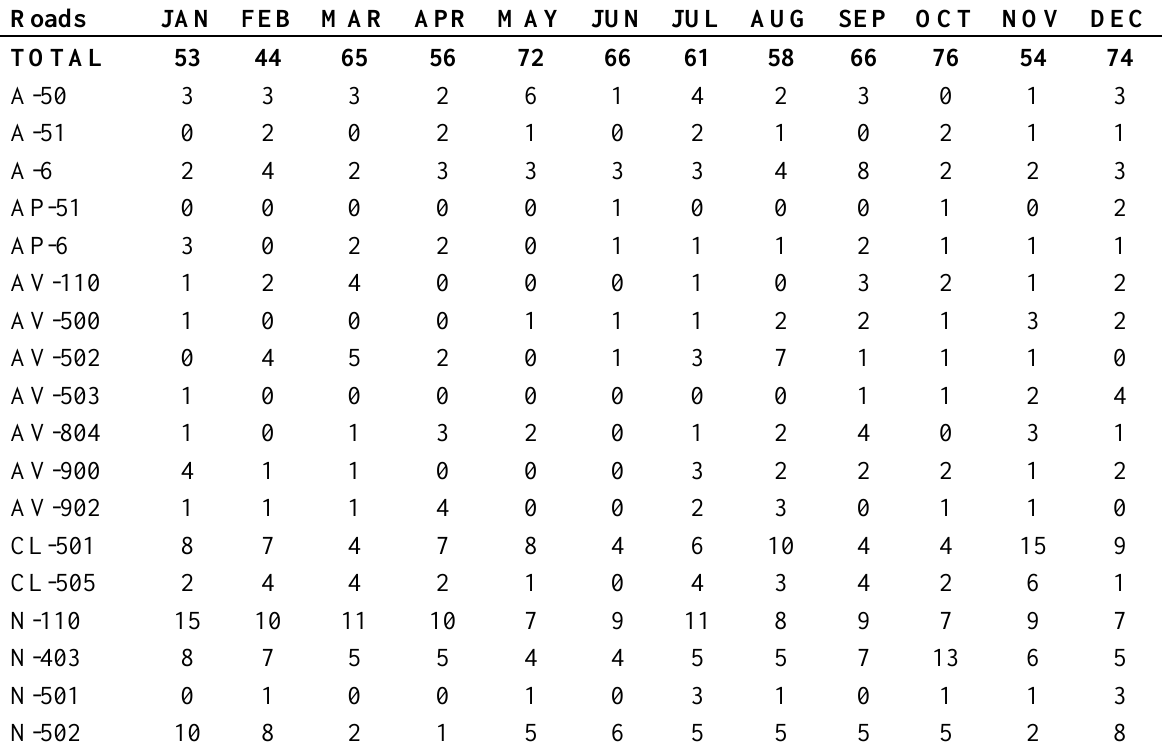
Table 2. Accidents in